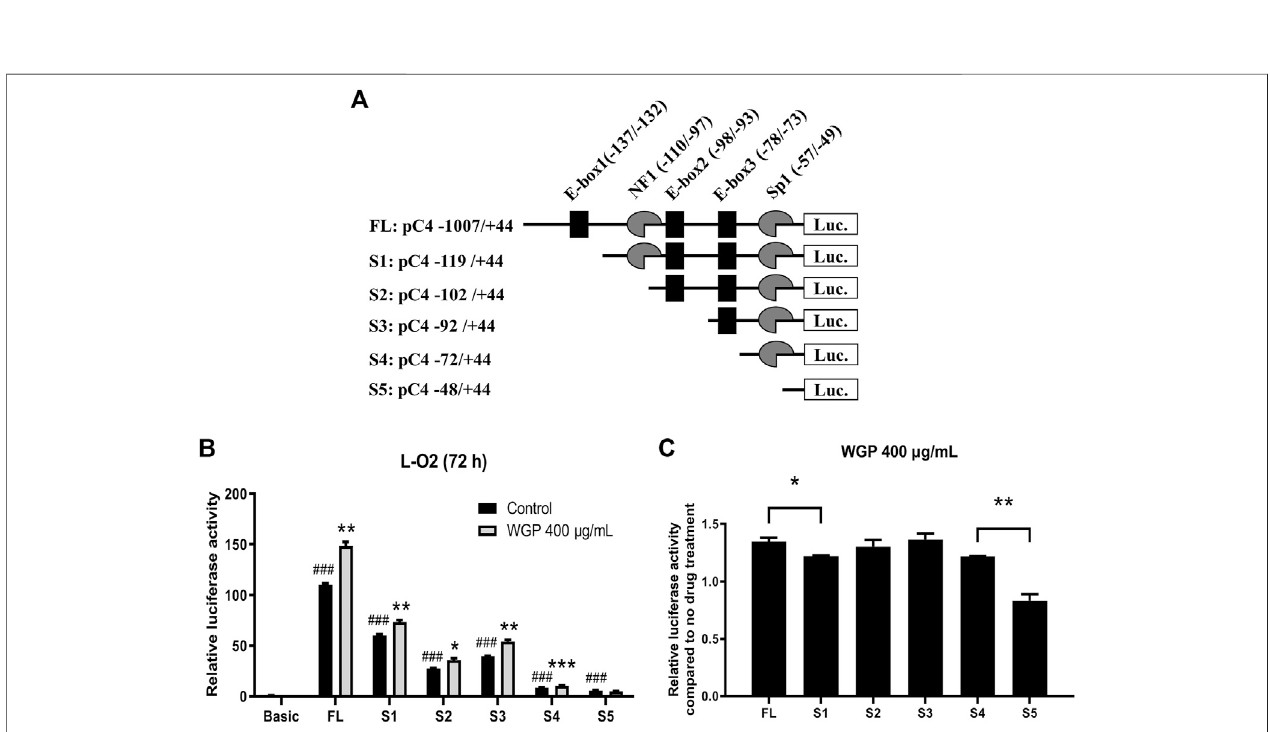
FIGURE 6 | WGP enhance C4 transcription via the E-box1 and Sp1 elements. (A) The critical cis-regulatory elements (NF-1, E-box1 ∼ 3, Sp1) on the plus (+) and minus (-) DNA strand are shown. Numbering is relative to the C4 translation start site. A series of 5 ’ -deletion constructs were generated by PCR ampli fi cation and subcloningintothepGL4.19basicvector. (B) TheC4promoterconstructsweretransientlytransfectedintoL-O2cells.Luciferaseassaywasusedtomeasuretheactivity ofC4promoter. *indicates p < 0.05, **indicates p < 0.005,and ***indicates p < 0.001comparedtonodrugtreatmentcontrol. ###indicates p < 0.001compared tobasicvectorcontrol. (C) FoldchangesofWGPtreatmentcomparedtovehiclecontrolaregraphed.*indicates p < 0.05and**indicates p < 0.005.Dataarepresented as mean of triplicates ± SEM from one representative experiment.